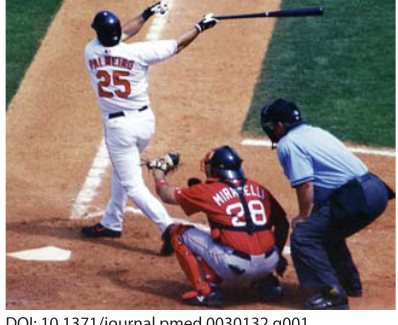
Figure 1. Pfi zer Hired 39-Year-Old Baseball Player Rafael Palmeiro as a Spokesman